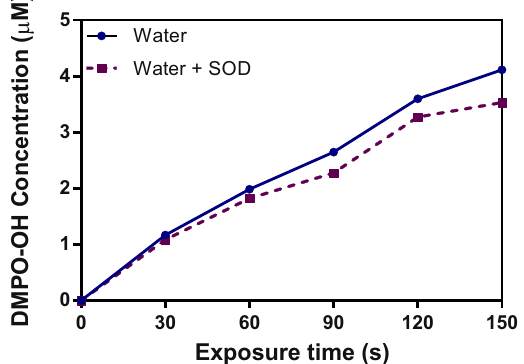
Figure 3. Variation of DMPO-OH concentration in Milli-Q water with or without 150 U of SOD after He plasma treatment at various exposure time. Half height of the second peak of the quartet spectrum was chosen to represent DMPO-OH intensity.